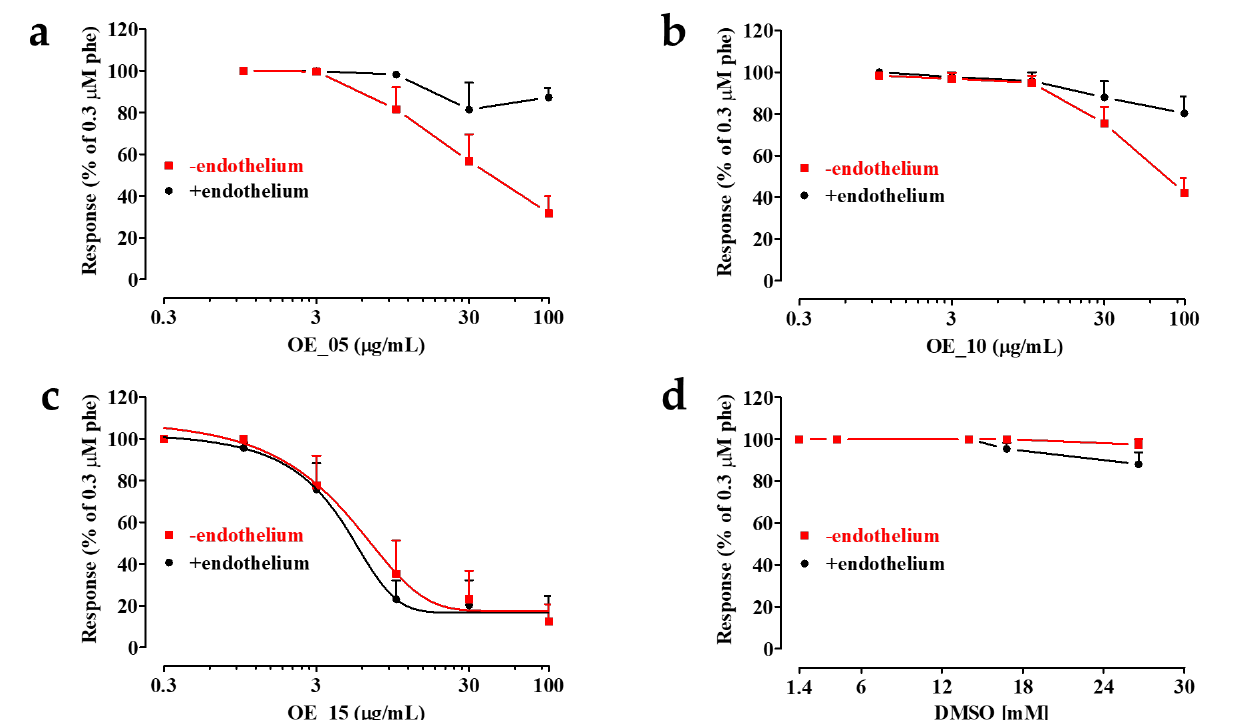
Figure 6. Effect of the EVOO extracts on phenylephrine-induced contraction of rat aorta rings. Concentration-response curves of ( a ) OE_05 , ( b ) OE_10 , and ( c ) OE_15 on endothelium-denuded (-endothelium) or endothelium-intact (+endothelium) preparations pre-contracted by 0.3 µM phenylephrine (phe). ( d ) The effects of the vehicle DMSO are shown. In the ordinate scale, the response is reported as a percentage of the initial tension induced by phenylephrine, taken as 100%. Data are means ± SEM ( n = 5 – 9).